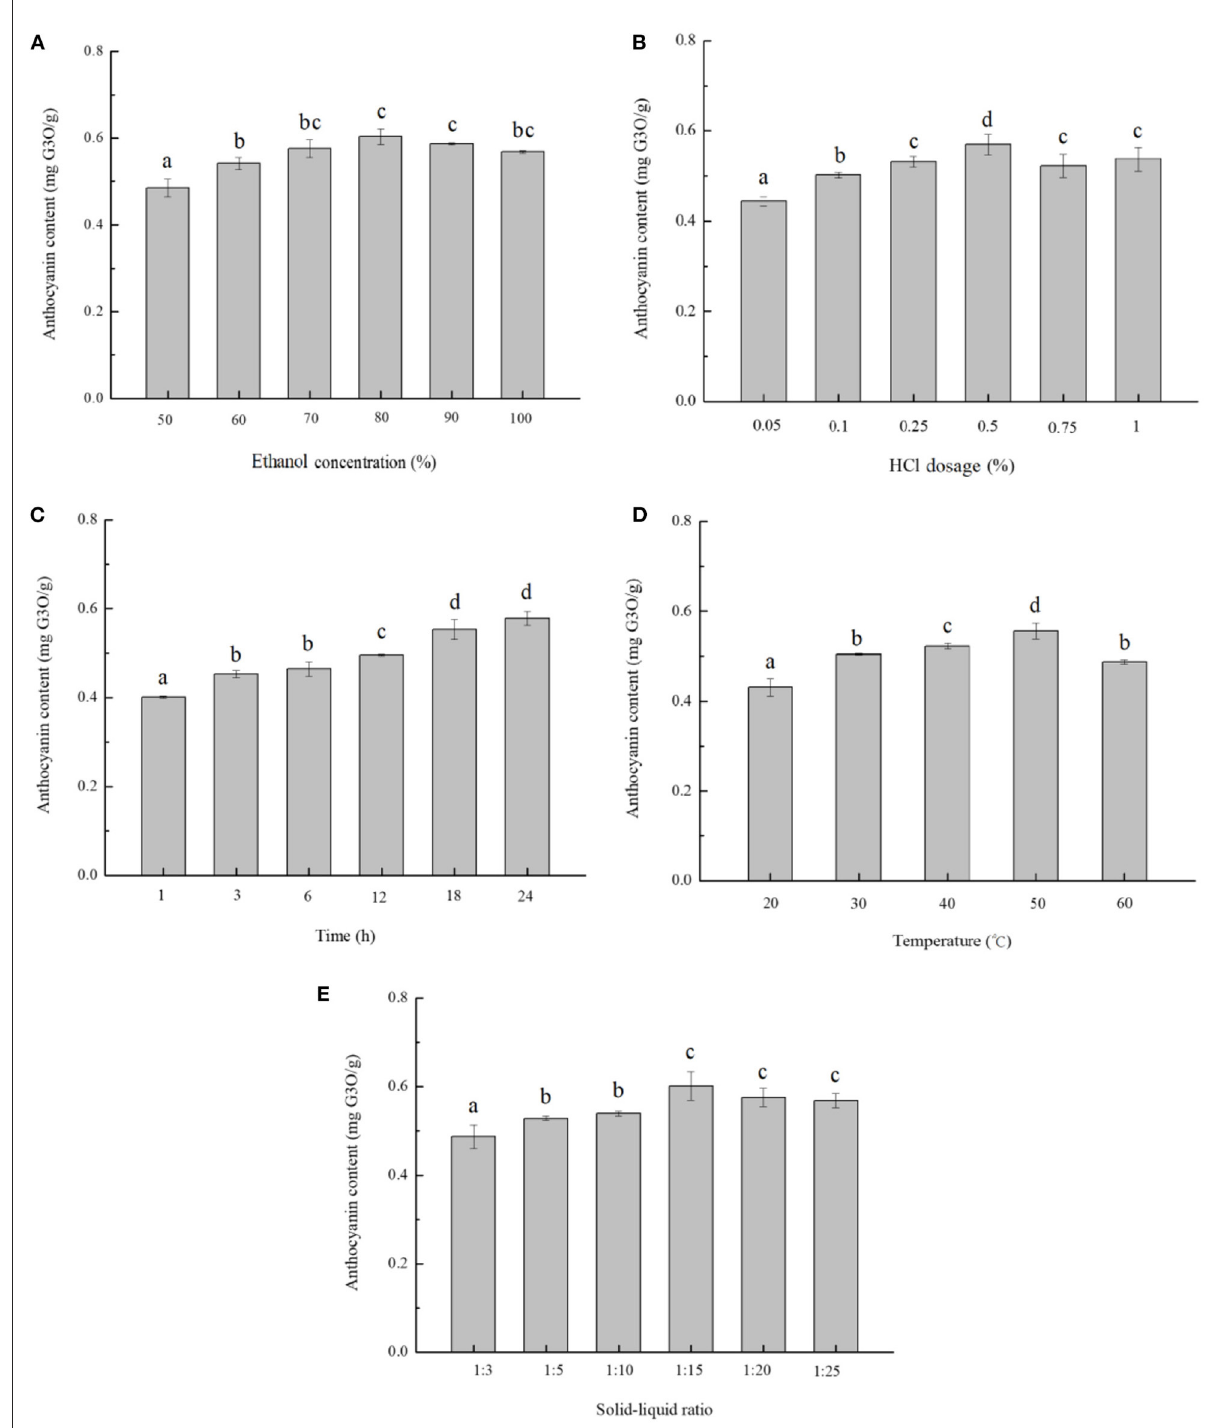
FIGURE1 Single-factor analysis of anthocyanin extraction from blackberry. The effects of different extraction parameters: (A) ethanol concentration, (B) HCl concentration, (C) extraction time, (D) extraction temperature, and (E) solid-to-liquid ratio on anthocyanin extraction yield were studied. The mean values in the same figure with different lowercase letters were significantly different at the level of